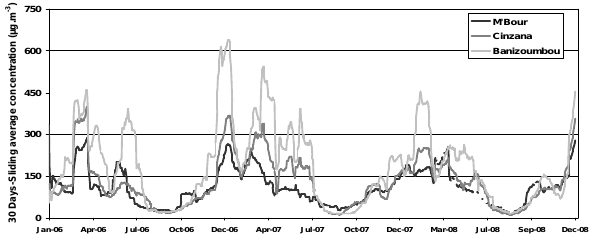
Fig. 9. 30-days sliding average of the daily mean concentration at the three stations of the Sahelian Dust Transect from January 2006 to December